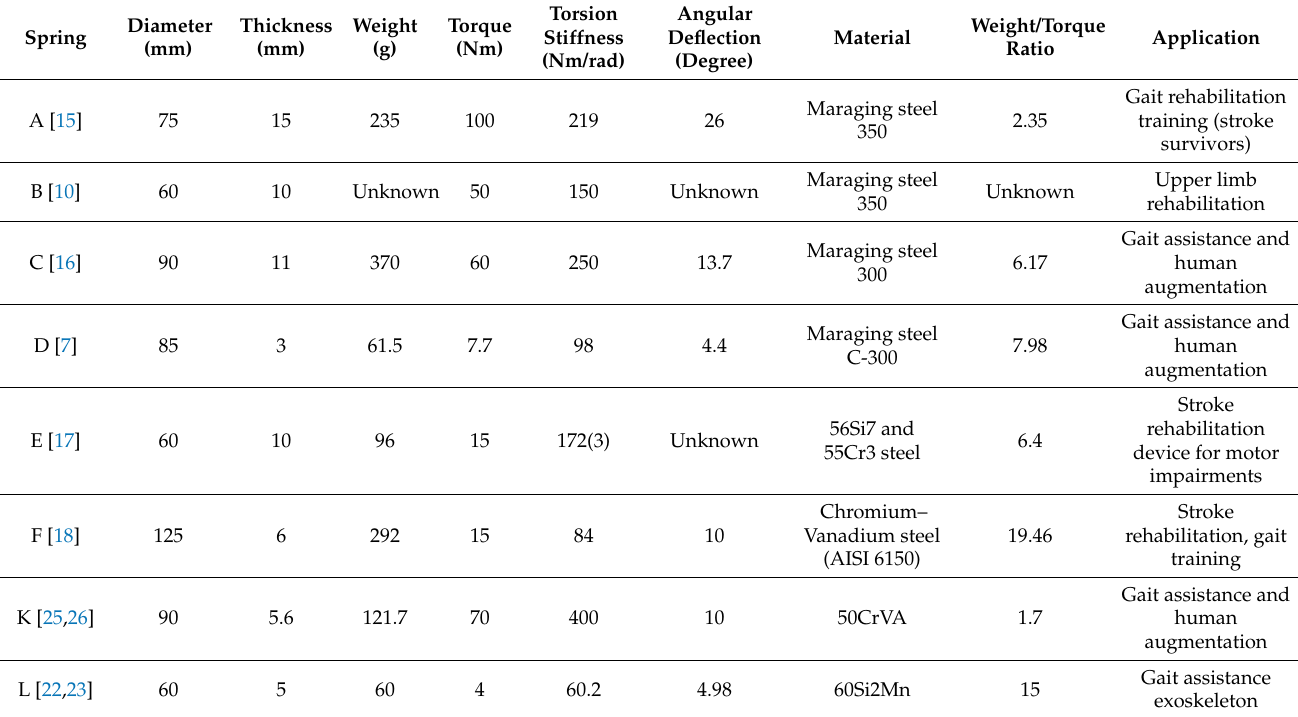
Table 1. Comparisons of the main features of existing torsion spring